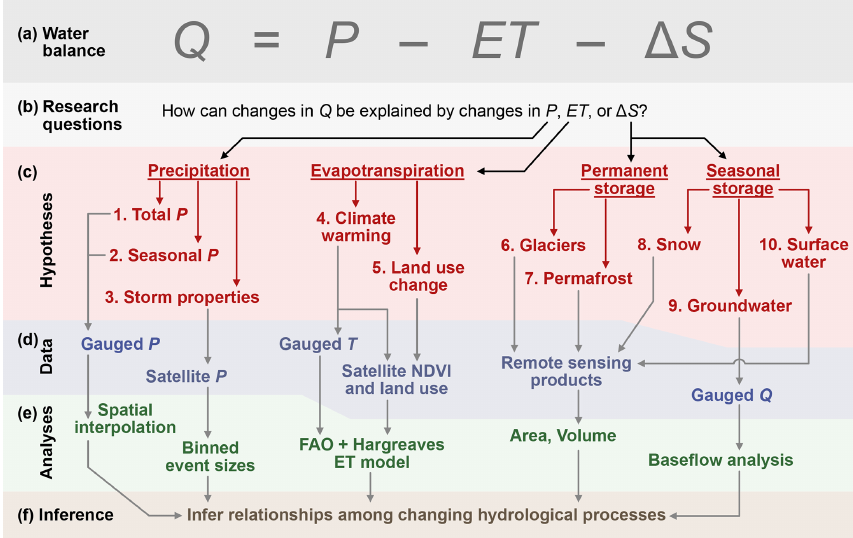
Figure 2. Hypothesis generation and evaluation. We develop a general empirical approach to attribution that (a) utilizes the water balance to (b) generate overarching research questions and (c) construct multiple hypotheses. The hypotheses are addressed (d) using remote sensing and in situ secondary data and (e) by applying empirical analyses, the results of which are (f) used to infer relationships regarding changing hydrological processes. We implement this approach in the Upper Jhelum watershed by defining the long-term water balance in terms of streamflow ( Q ), precipitation ( P ), evapotranspiration (ET), and changes in catchment water storage ( (cid:49)S ). Specific research questions (red), data (blue), and analyses (green) focus on the detection and characterization of changing water balance fluxes in the Upper Jhelum watershed. The inference step is contingent on understanding how each flux has changed and provides a deeper understanding of watershed hydrological